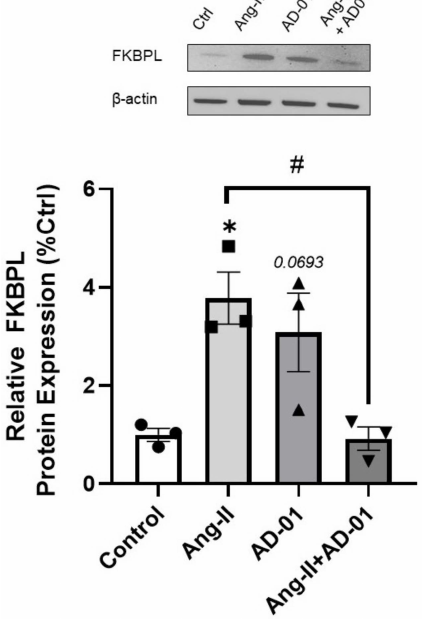
Figure 3. FKBPL protein expression in H9C2 cardiomyocytes following Ang-II and/or AD-01 treatment. H9C2 cells were exposed to treatment groups (i) Ang-II (100 nM), (ii) AD-01 (100 nM) and (iii) Ang-II (100 nM) + AD-01(100 nM) for 48 h. Relative FKBPL expression was measured. Results expressed as Mean ± SEM ( n = 3); One-way ANOVA with Tukey’s post-hoc; * p < 0.05 against control; # p < 0.05 against Ang-II group. Ang-II—angiotensin II; AD-01—FKBPL-based therapeutic peptide.